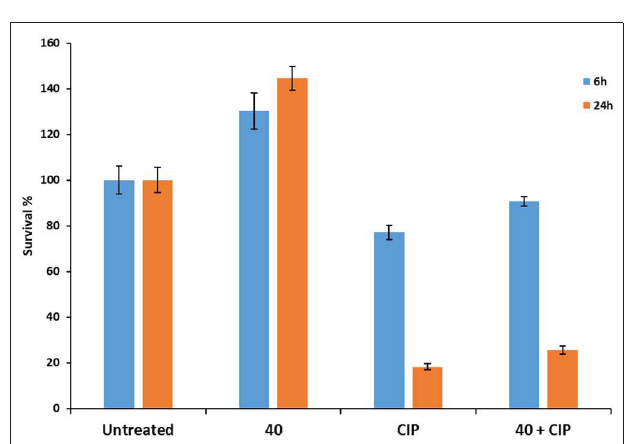
FIGURE 7 | Bar chart showing PAO1-L biofilm viability quantified after treatment with different conditions for 6 or 24h. The concentrations of